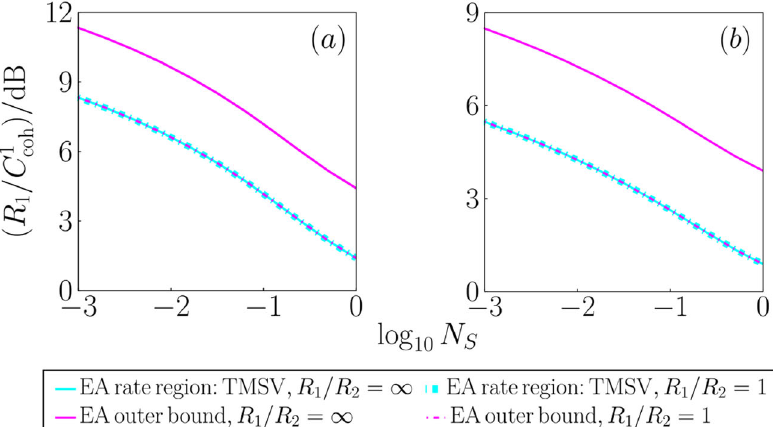
Fig. 6 Rates versus signal brightness. The dependence on source brightness N S,1 = N S,2 = N S of the EA advantage of the EA rate regions for two-sender MAC communication under the scenario of: a microwave domain η = 1/2, τ = 0.01, N B = 20; b long wavelength infrared domain = η = 1/2, τ = 0.001, N = 0.1. We plot R η 1 2 B 1 for sender 1 under conditions R 1 / R 2 curves overlap. Note that